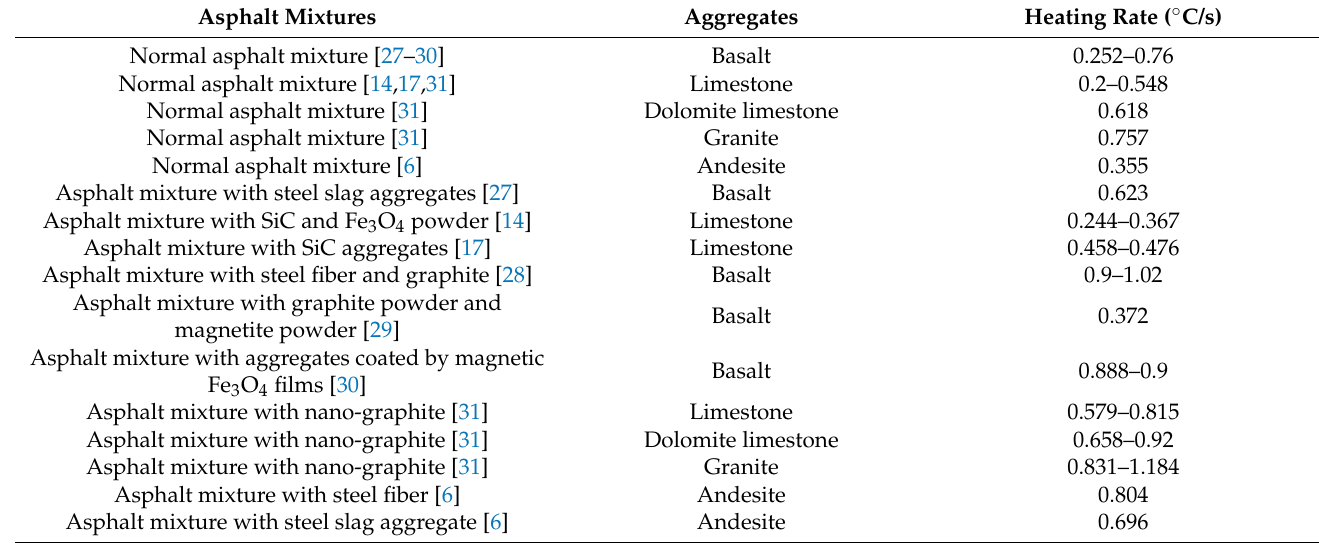
Table 2. The heating rate of different asphalt